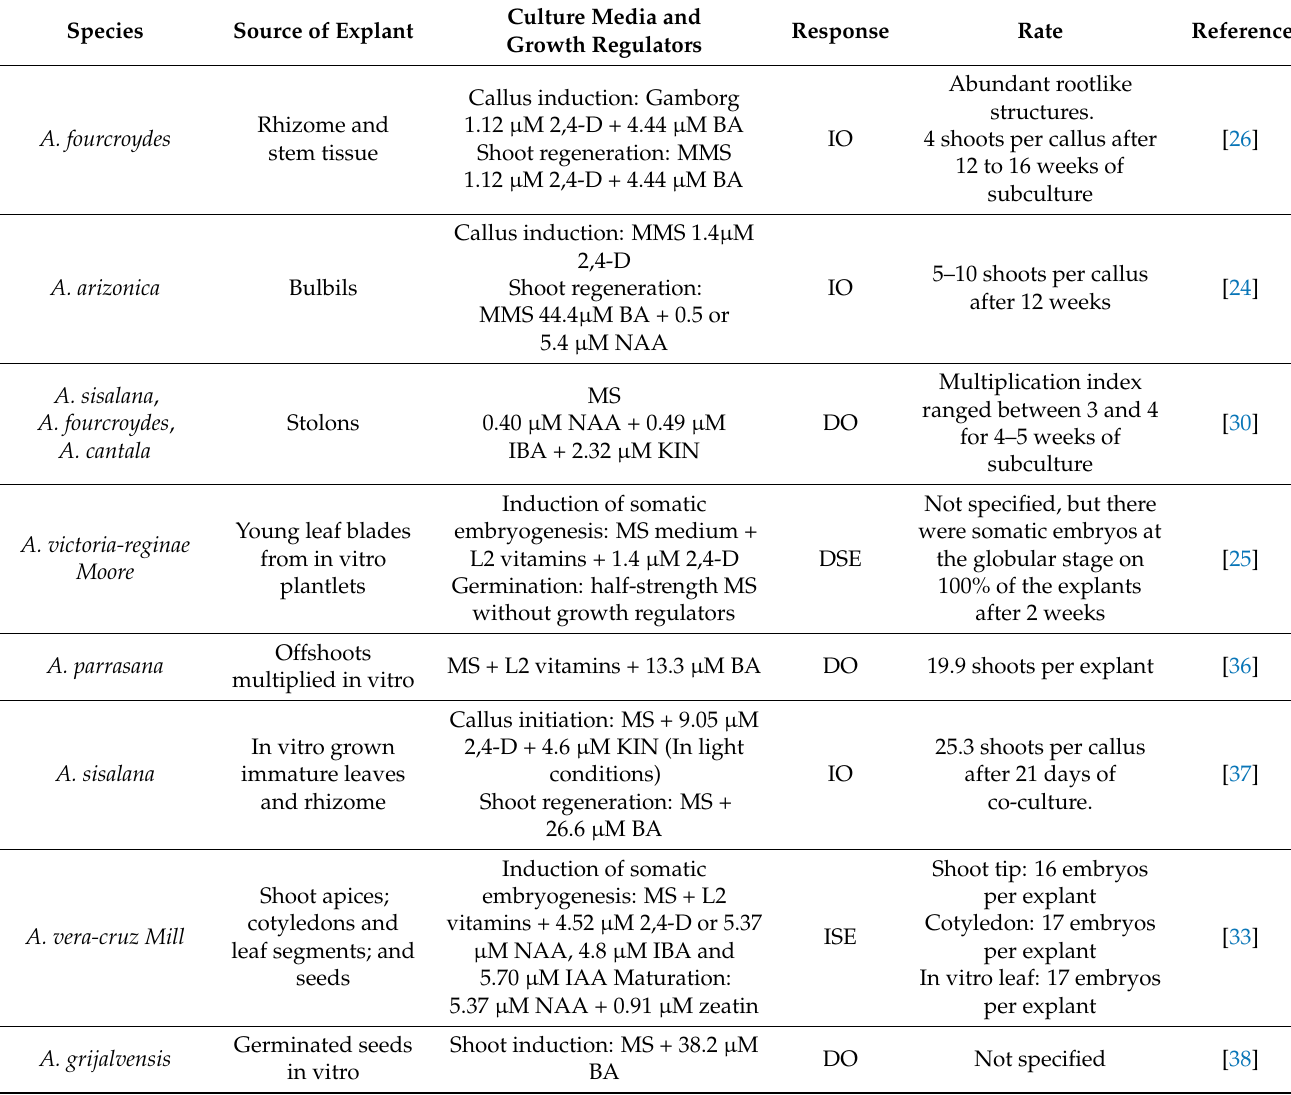
Table 2. Micropropagation protocols for Agave